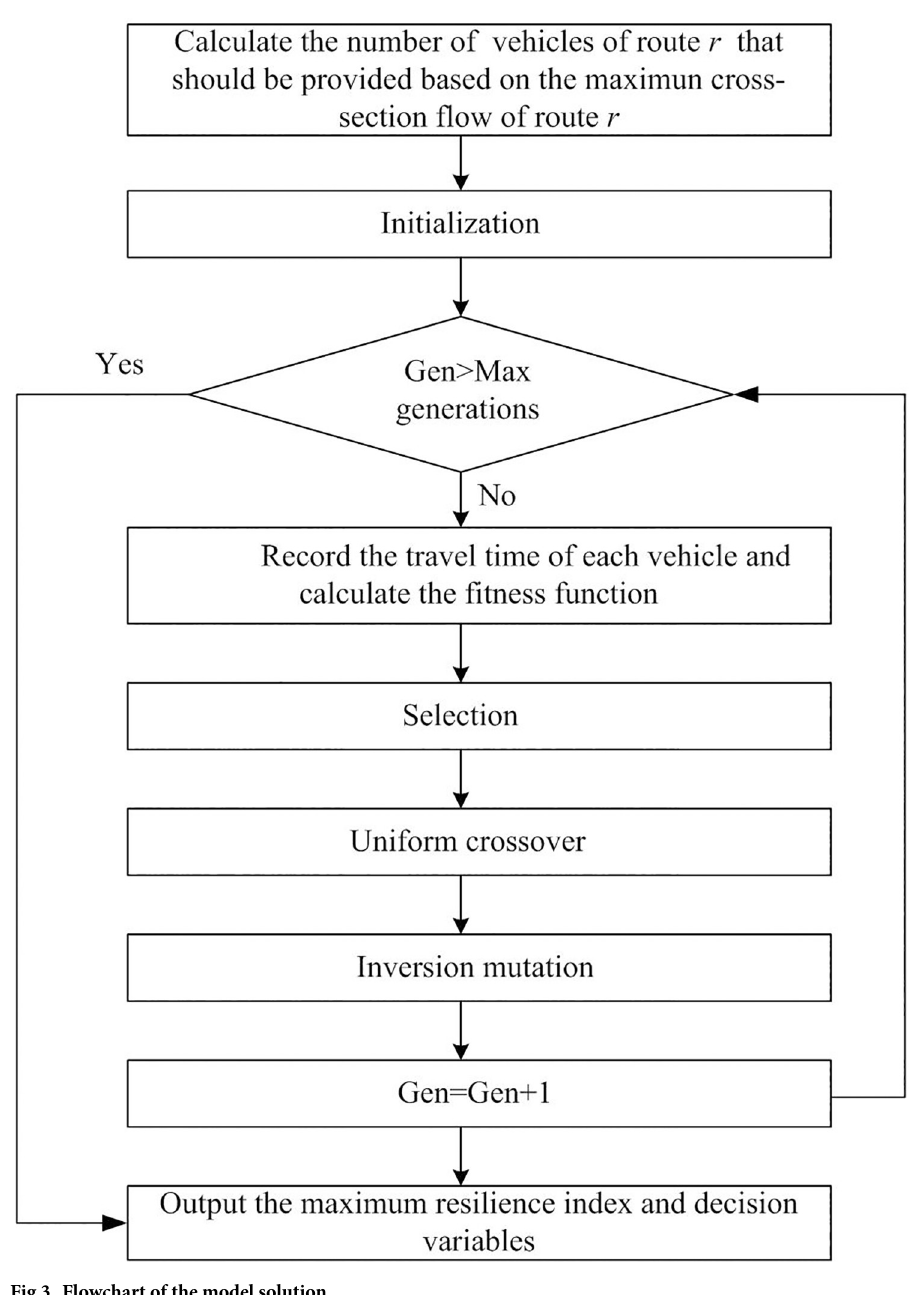
Fig 3. Flowchart of the model